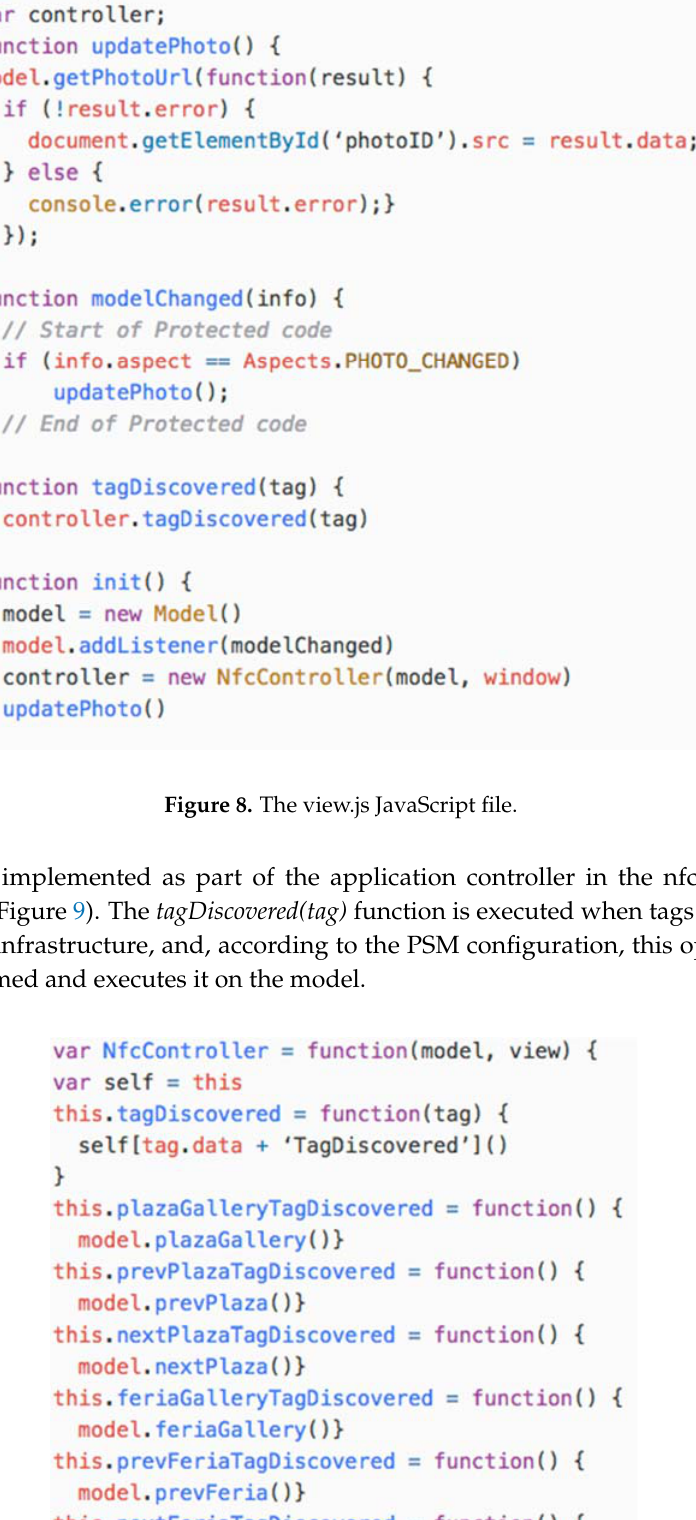
Figure 9. The nfc ‐ data ‐ controller.js JavaScript file.